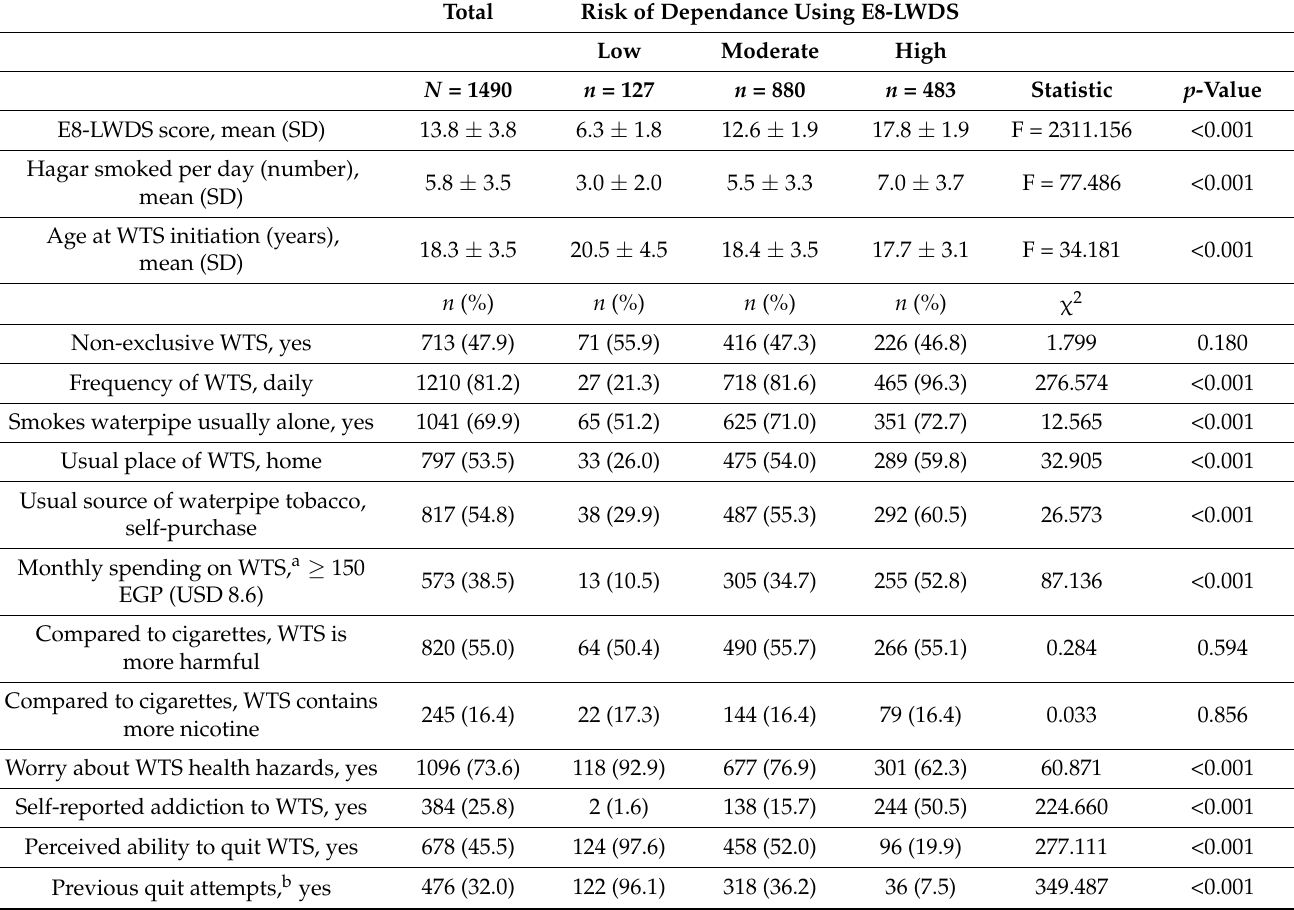
Table 3. Associations between risk of dependence using E8-LWDS and current waterpipe tobacco smokers’ pattern, perceived harm, and perceived behavioral control.